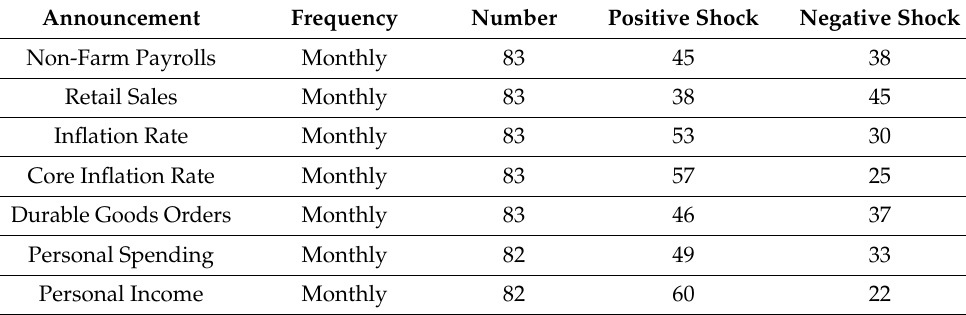
Table 3. Summary about US macro announcements used in the